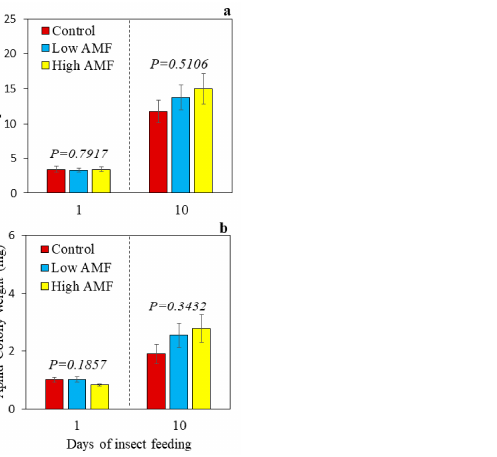
Figure 1. Potato aphid ( Macrosiphum euphorbiae ) ( a ) number per colony (per plant) and ( b ) weight per colony after one and ten days of herbivory on non-mycorrhizal potato plants ( Solanum tuberosum ) (Control), plants with a low level of AM fungal root colonization (Low AMF), and plants with a high level of AM fungal root colonization (High AMF). Values represent the mean of seven biological replicates ± SEM. A p ≥ 0.05 indicates no statistical significance based on